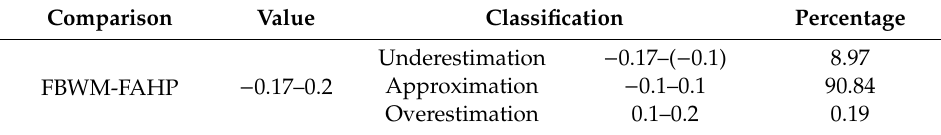
Table 7. Classification of comparison